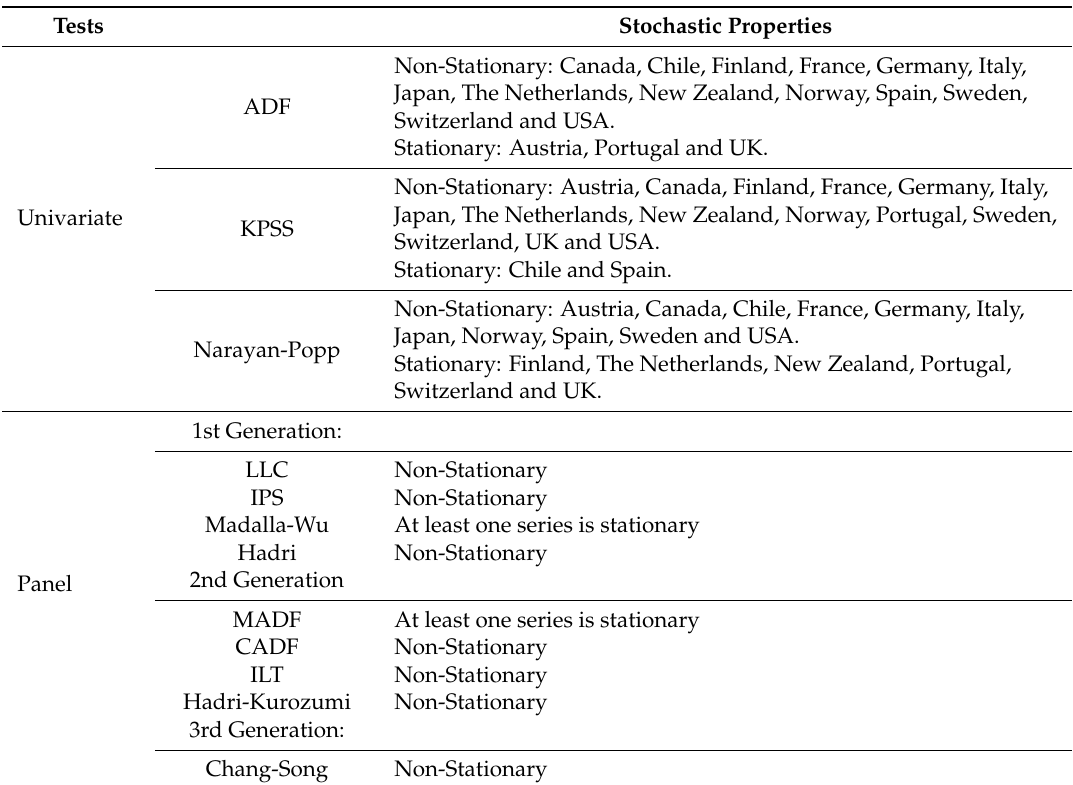
Table 3. Summary of